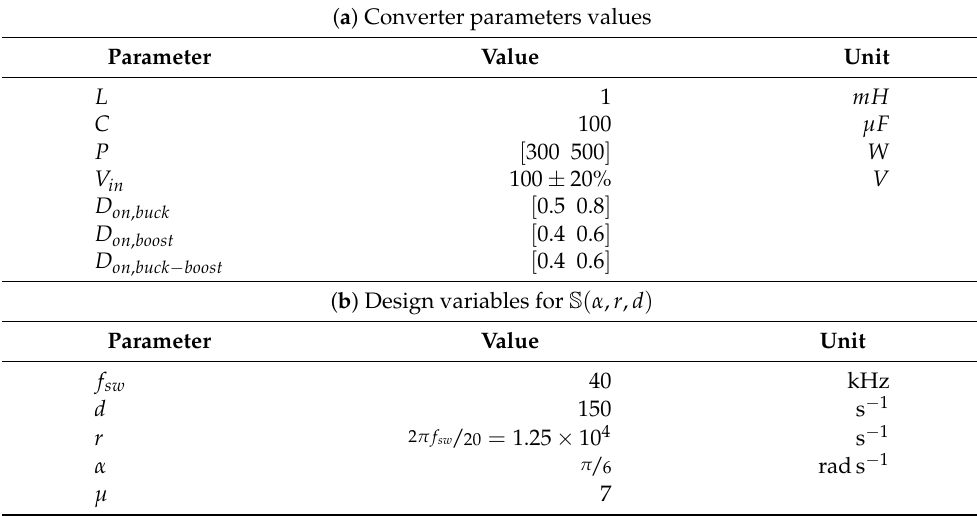
Table 4. Numerical values of converters: CPL approach. ( a ) Converter parameters